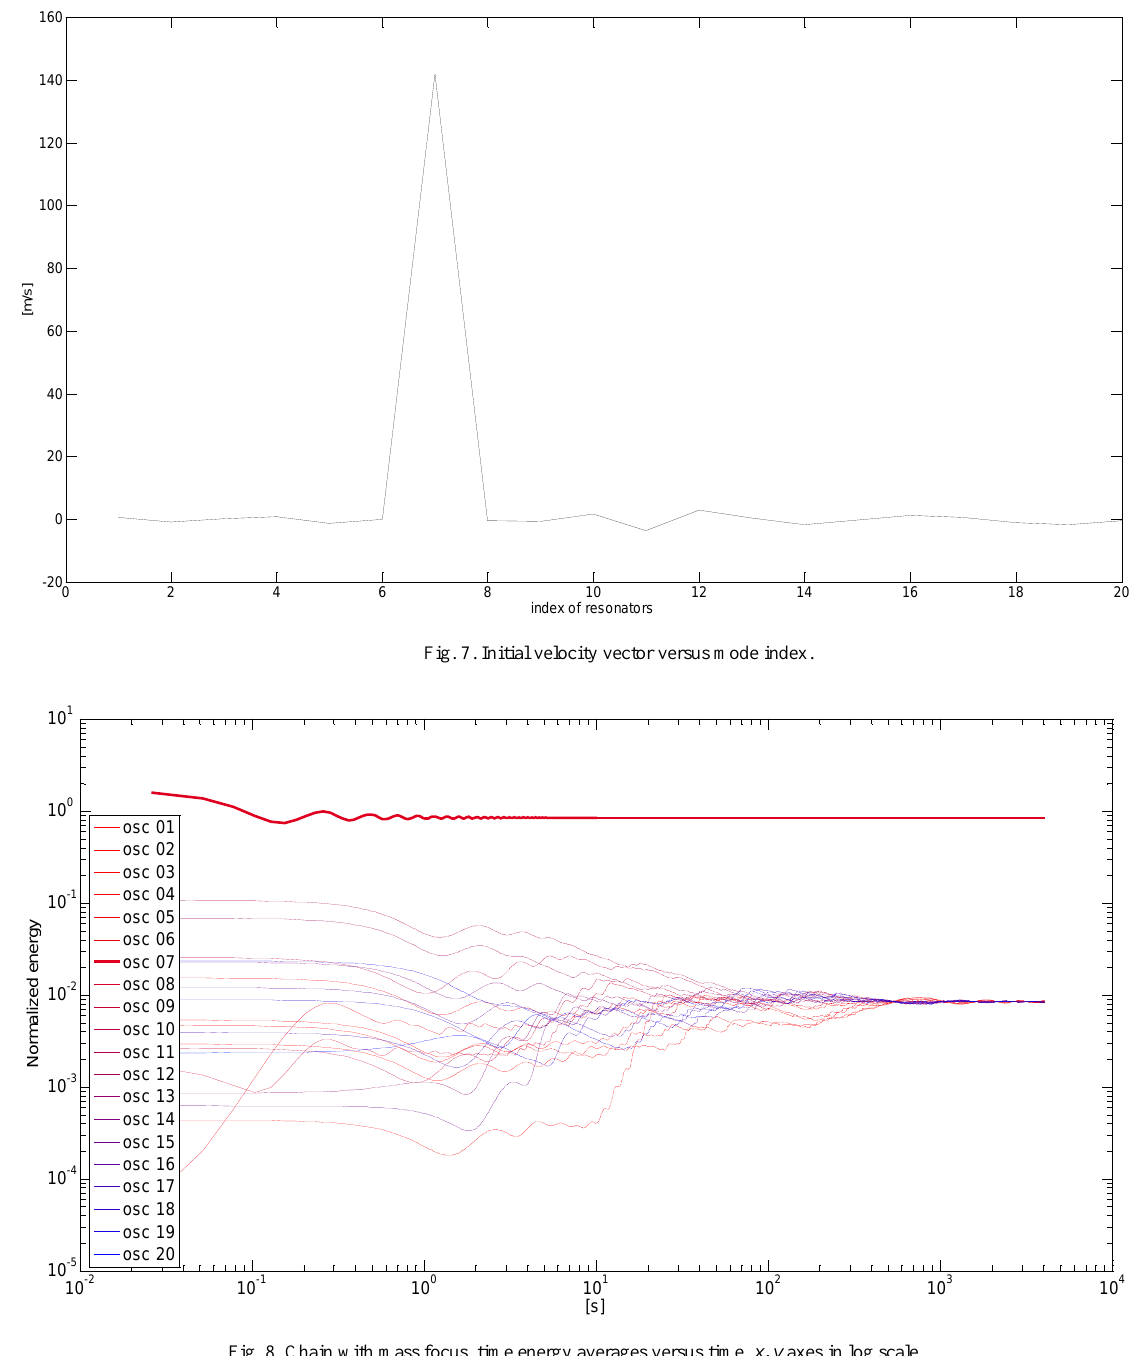
Fig. 8. Chain with mass focus, time energy averages versus time, x, y axes in log